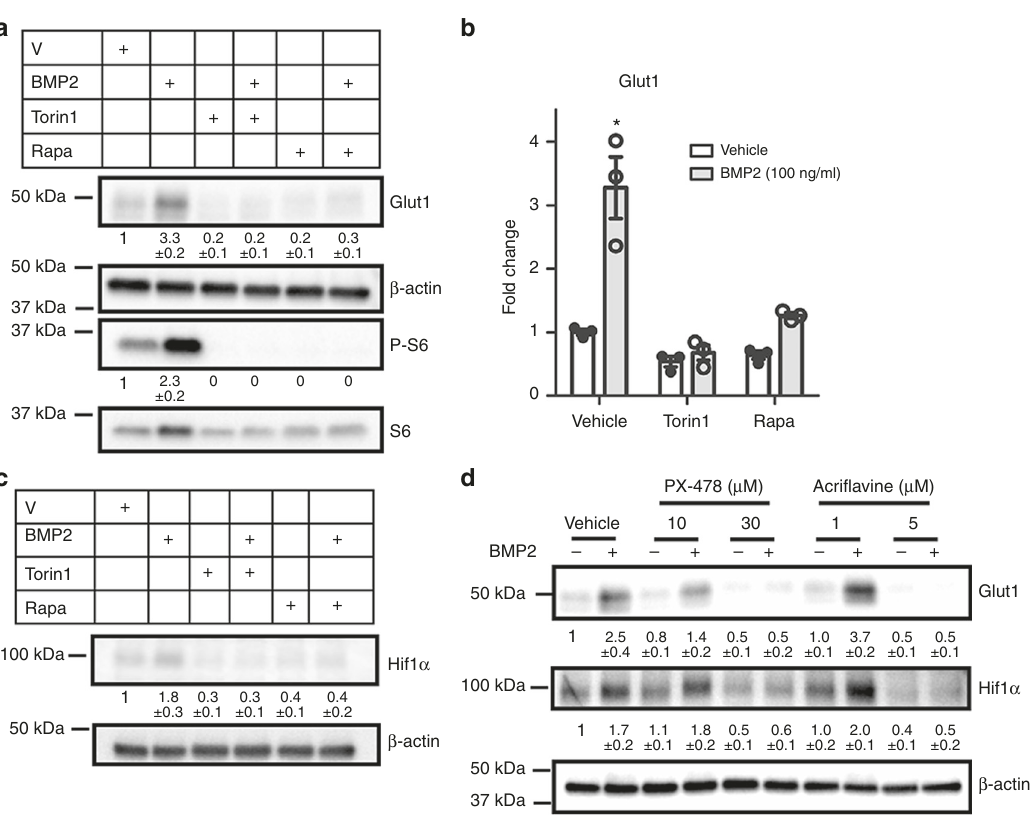
Fig. 9 Hif1 α mediates Glut1 induction downstream of Bmp-mTORC1 signaling. a – c Western blot ( a , c ) or RT-qPCR ( b ) analyses in primary chondrocytes after 24 h of BMP2 treatment with or without mTOR inhibitors. Rapa: rapamycin. d Western blot analyses in primary chondrocytes in response to BMP2 with or without the Hif1 α inhibitors for 24 h. Quanti fi cation of all western blots denotes average fold change over vehicle control after normalization to β - actin (±SD, n = 3). * p < 0.05, n = 3, error bar indicates SD, two-tailed Student ’ s t-